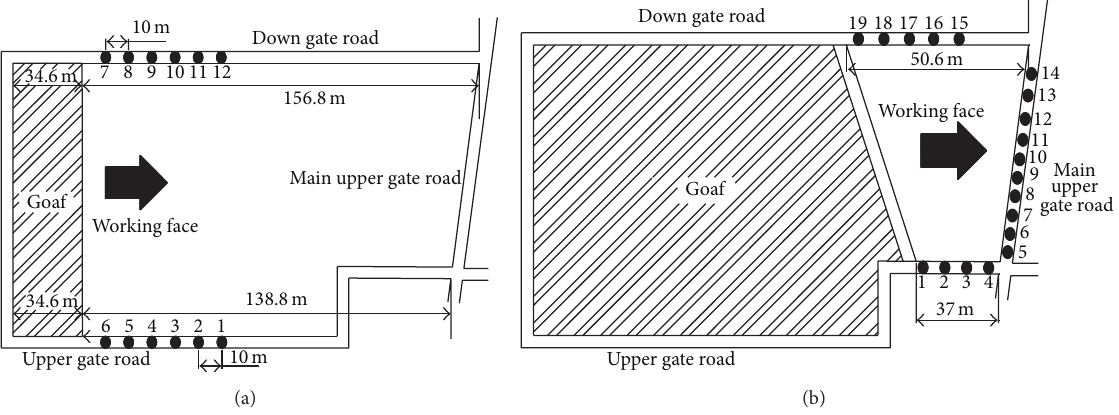
Figure 9: Monitoring disposal around coalface at the (a) early and (b) final stage of extraction.